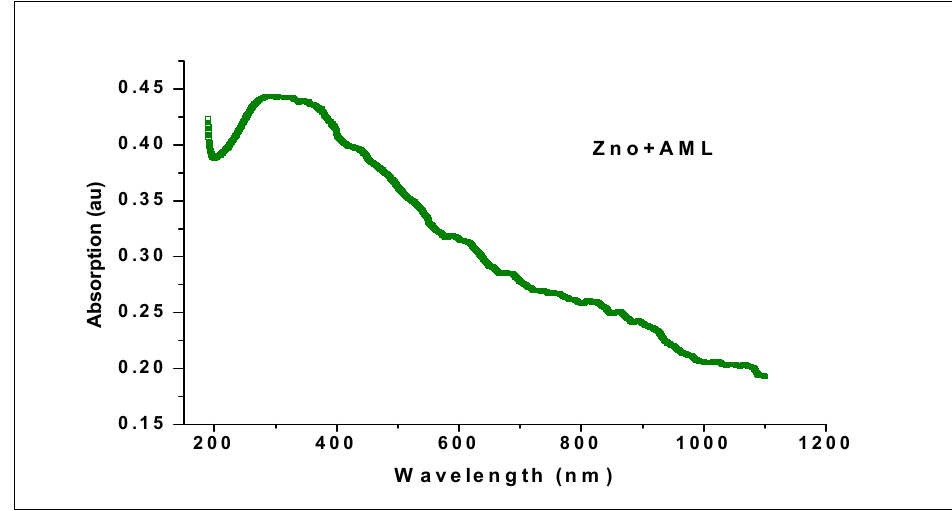
6 of 11 Figure 5. EDAX Spectrum of Zno Nps. Table 3. EDAX Analysis for Zinc Nanoparticles. Sample At of (Zn) At of (O) ZNp 32.05 34.58 2.5. Ultraviolet—Visible (UV-Vis) Spectroscopy